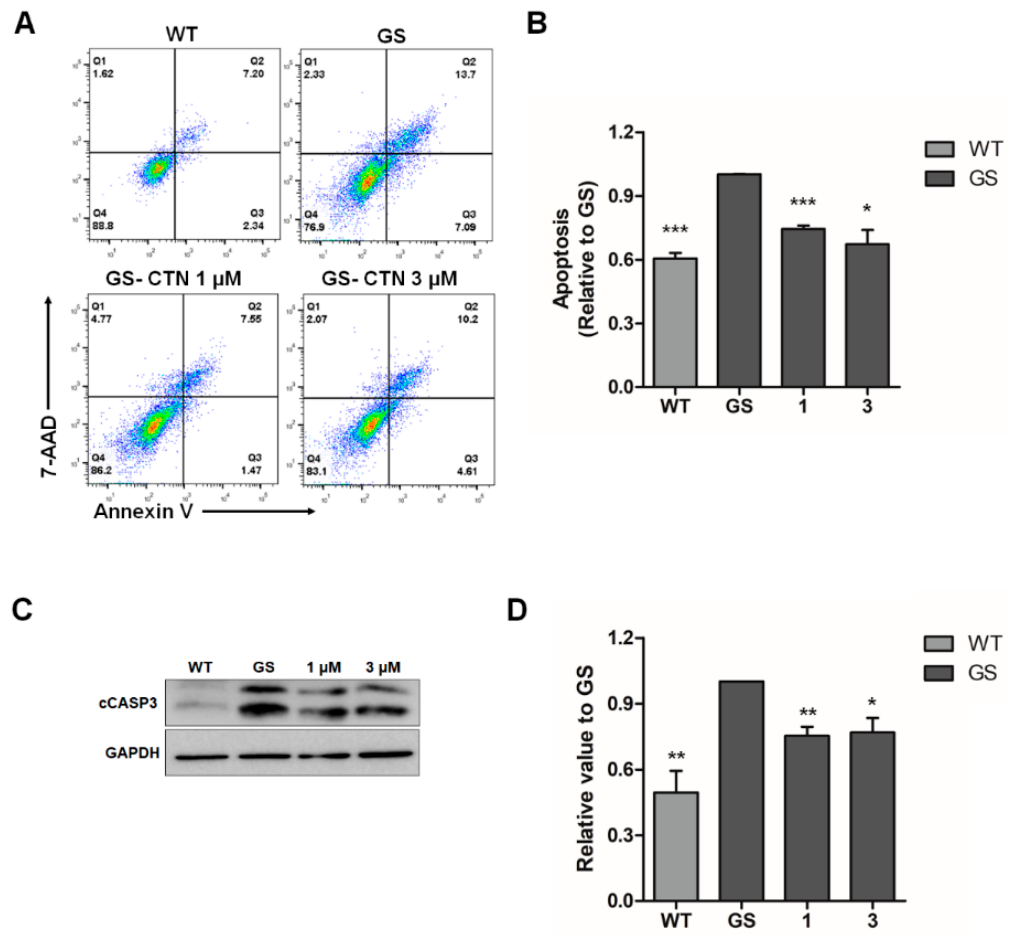
Figure 3. Effects of CTN on MG132-induced apoptosis in GS hiNPCs. ( A ) MG132-induced apoptotic cell death and recovery by CTN treatment were evaluated through Annexin V / 7-AAD staining. ( B ) Quantification of apoptotic cells by flow cytometry. ( C ) Cell lysates from CTN-treated hiNPCs immunoblotted with the apoptosis marker cCASP3. GAPDH was used as an internal control. ( D ) Quantification of Western blots for cCASP3 normalized over GAPDH. Data are mean ± standard error of means (SEM) of at least three independent experiments. p -values were analyzed using the unpaired two-tailed Student’s t -test (* p < 0.05, ** p < 0.005, *** p < 0.001).